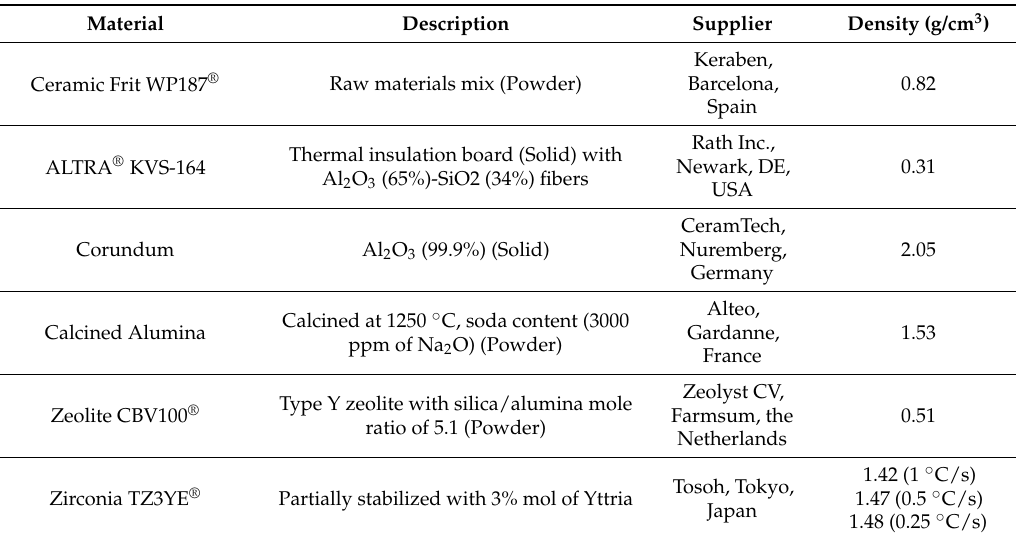
Table 2. Characteristics of the samples measured in this